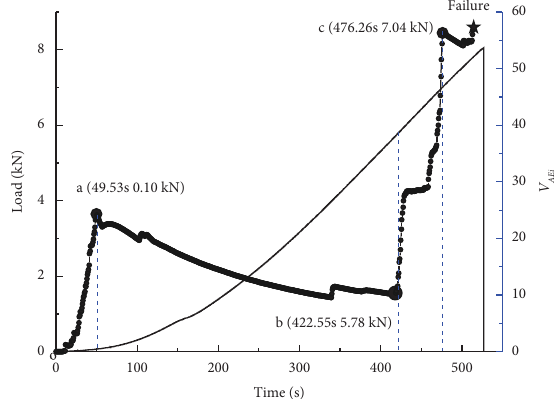
Figure 8: Evolution of the SF1 coal sample V